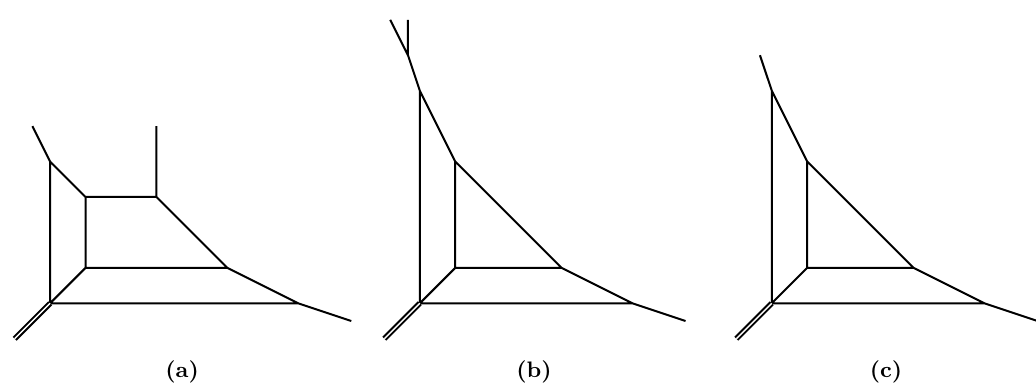
Figure 4. A 5-brane web construction for P 2 ∪ F 6 . Starting from the web diagram of SU(3) 4 theory (a), flop transition of two instantonic hypermultiplets gives (b). Integrating out the hypermultiplet gives a web diagram of P 2 ∪ F 6 depicted in